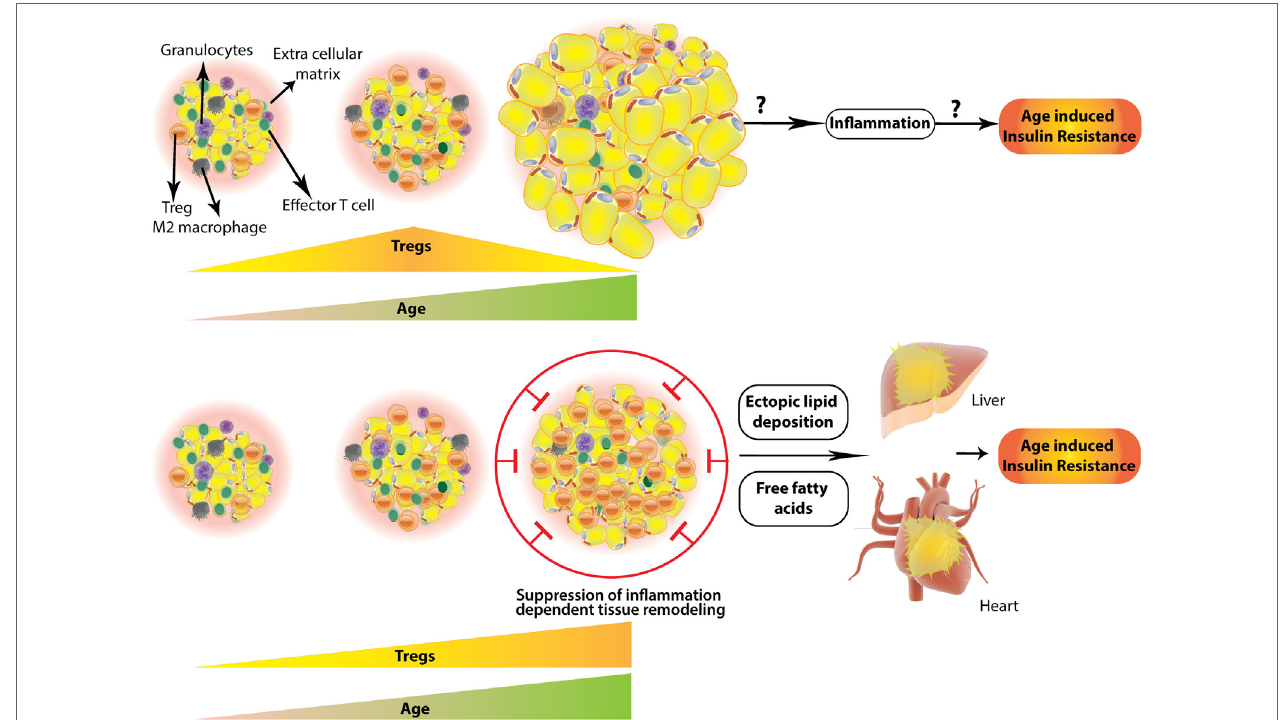
FiGURe 2 | Two contrasting scenarios of regulatory T-cells (Treg) numbers and their outcome in aged white adipose tissue (WAT). WAT Tregs increase with age reaching a plateau and then decrease abruptly in aged (~45 weeks) mouse (top). Whether this results in inflammation leading to age-associated insulin resistance is not explored; however, (bottom part) contrasting evidence suggest that white adipose Tregs keep on increasing even in the aged adipose tissue, which in concordance with “adipose tissue expandability hypothesis” (see text) results in suppression of healthy inflammation required for remodeling of adipose. This results in a storage space problem leading to ectopic deposition of fat in visceral organs, like liver and pericardium. This is accompanied by free fatty acid induced lipotoxicity and age-associated insulin